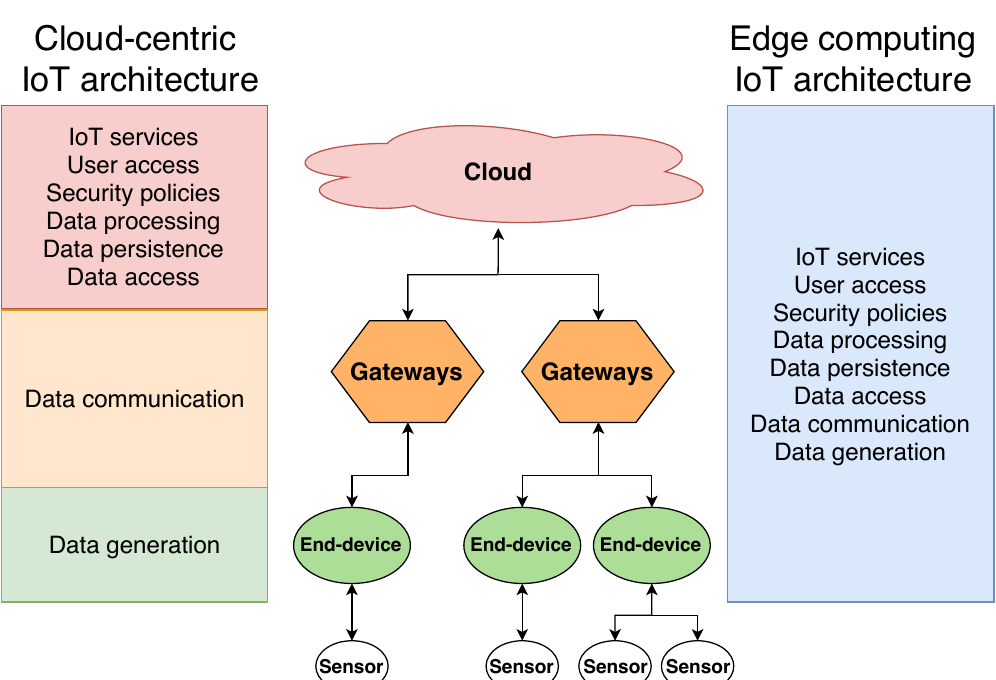
Figure 1. Cloud-centric IoT architecture vs. edge computing IoT